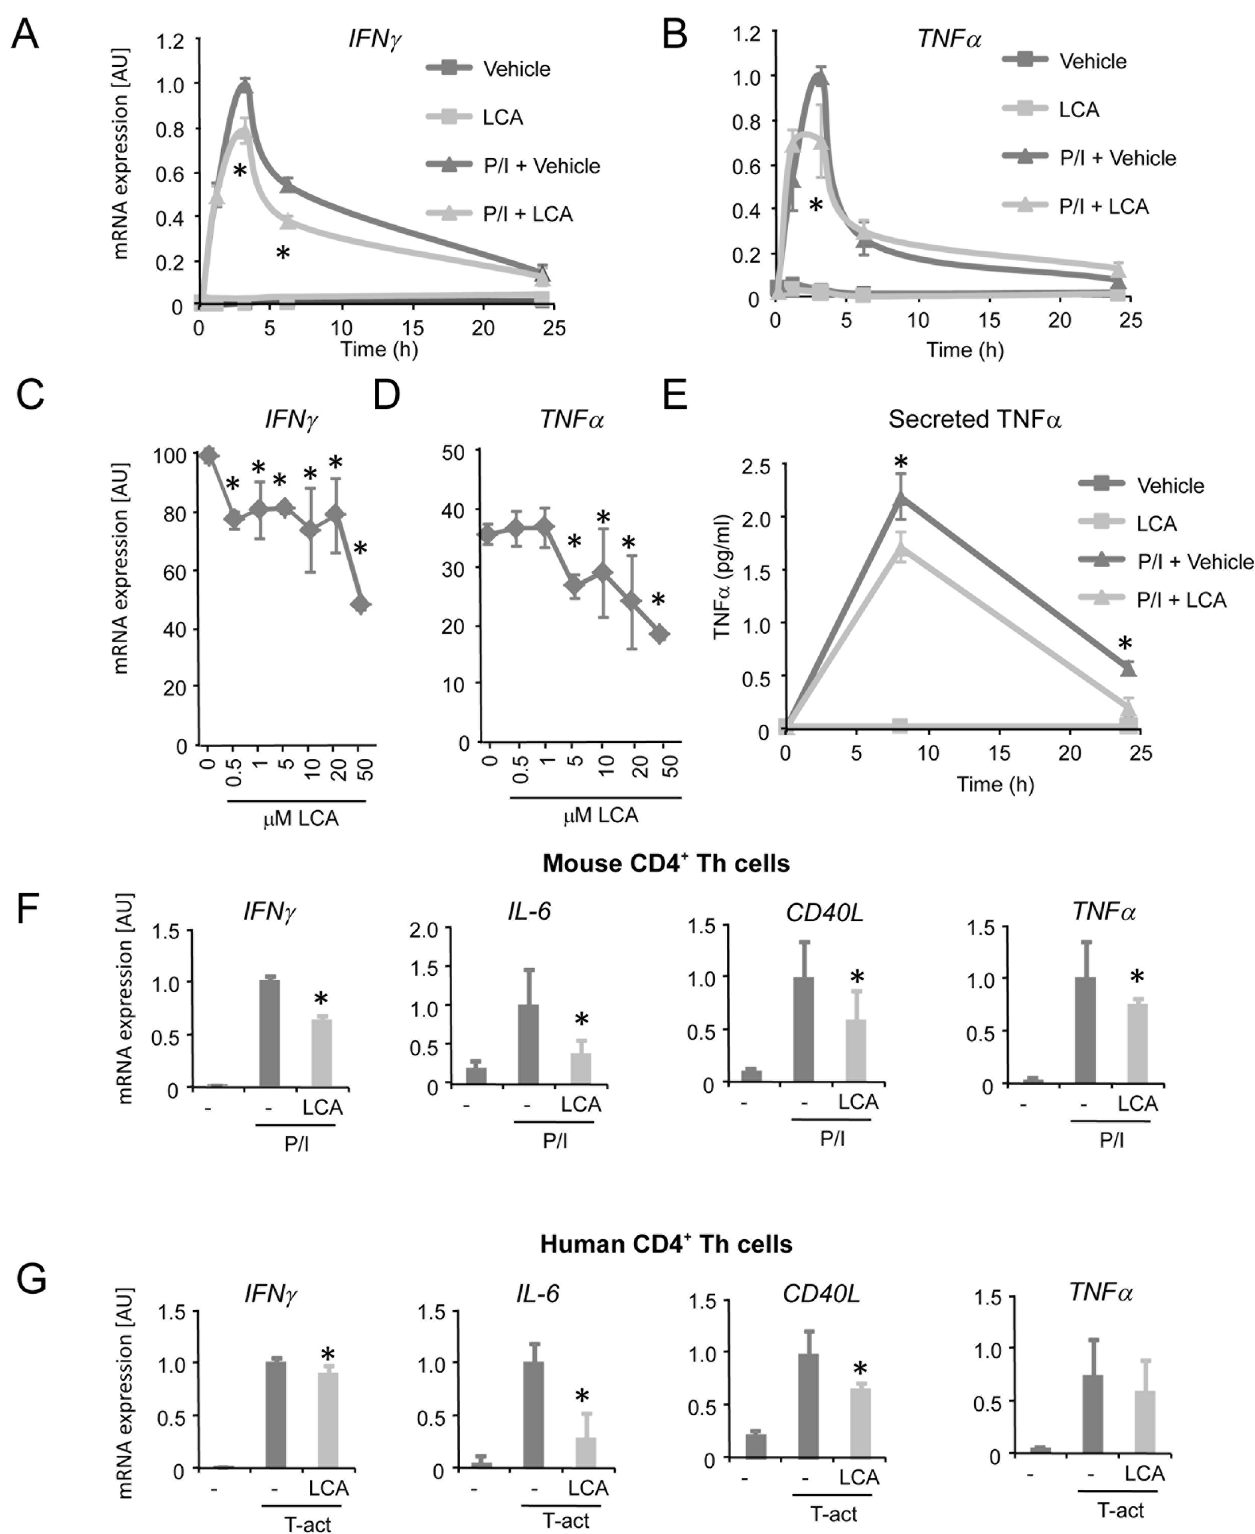
Fig 2. LCA inhibits CD4 + Th cell activation. (A) IFN γ mRNA expressionand (B) TNF α mRNA expressionin Jurkat T cells in responseto 10 μ M LCA treatment (light grey lines) or vehicle(dark grey lines)with P/I activation(triangles) or in resting Jurkat T cells (squares). (C) IFN γ and (D)